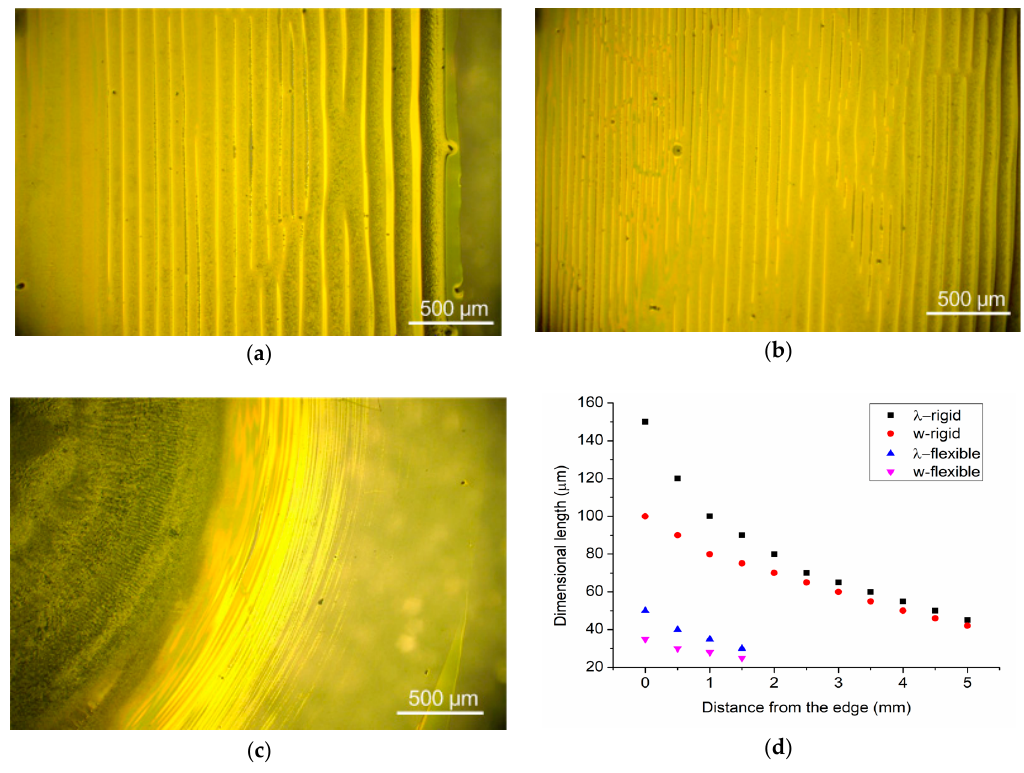
Figure 7. Optical microscope images of RR-P3HT obtained by evaporative self-assembly under rigid confinement ( a , b ) and flexible confinement ( c ) with a high solution concentration of 3 wt %. A thicker stripe pattern was obtained ( a ) near the edge and ( b ) distant from the edge; ( c ) very thick film surrounded by finer stripe patterns. ( d ) Comparison of periodicities ( λ ) and widths (w) of RR-P3HT stripe patterns resulted from the rigid and flexible cover plate.